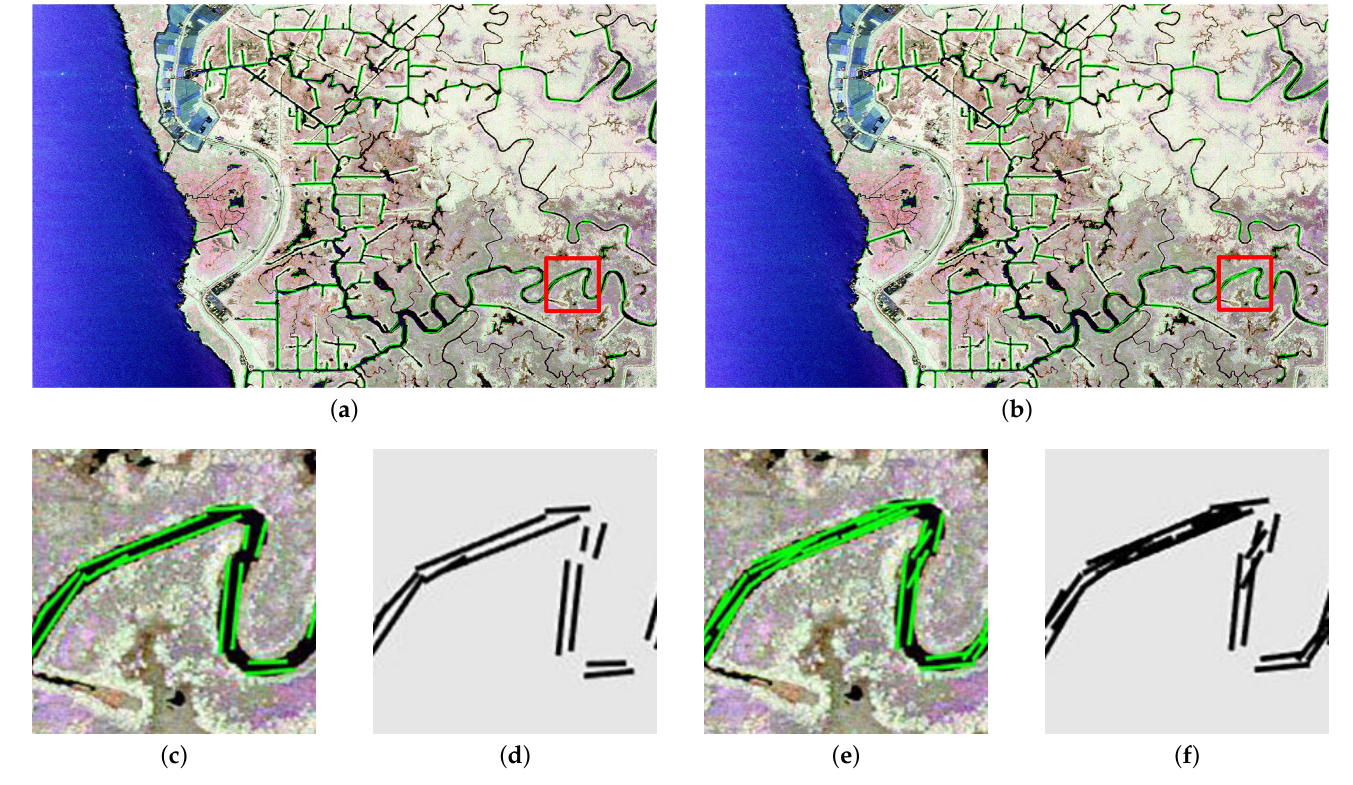
Figure 11. Enhancement of gradient strength. ( a ) With gradient strength. ( b ) Without gradient strength. ( c , d ) Enlarged results of the red rectangular areas in ( a ). ( e , f ) Enlarged results of the red rectangular areas in ( b ).